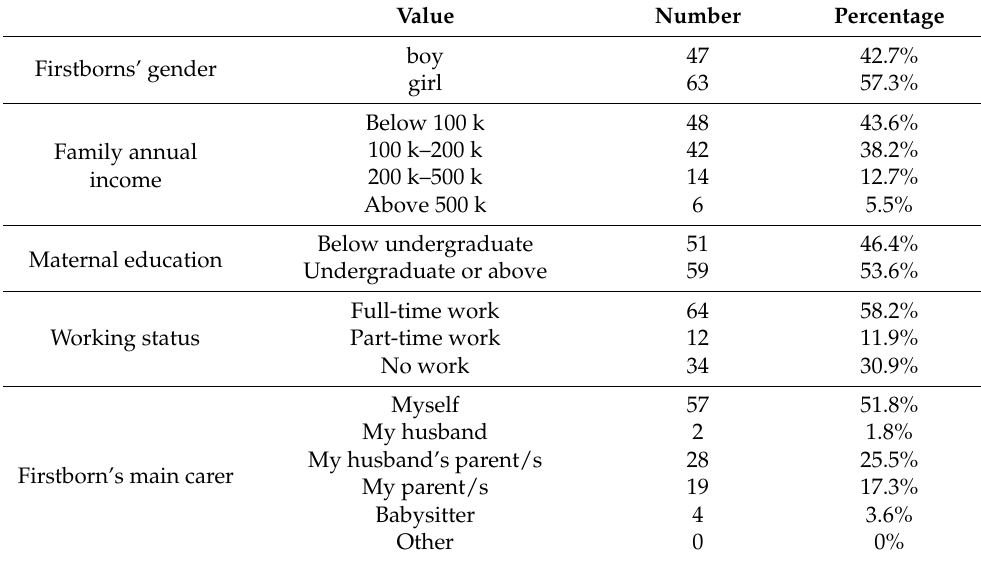
Table 1. Demographic information of the sample ( N =